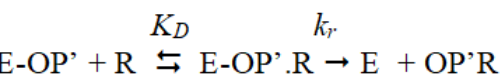
6 of 23 Figure 2. Coupled consecutive reactions between cholinesterase (E) phosphylation (E-OP’) by organophosphate (OPX = T) and oxime (R-O:)-mediated cholinesterase